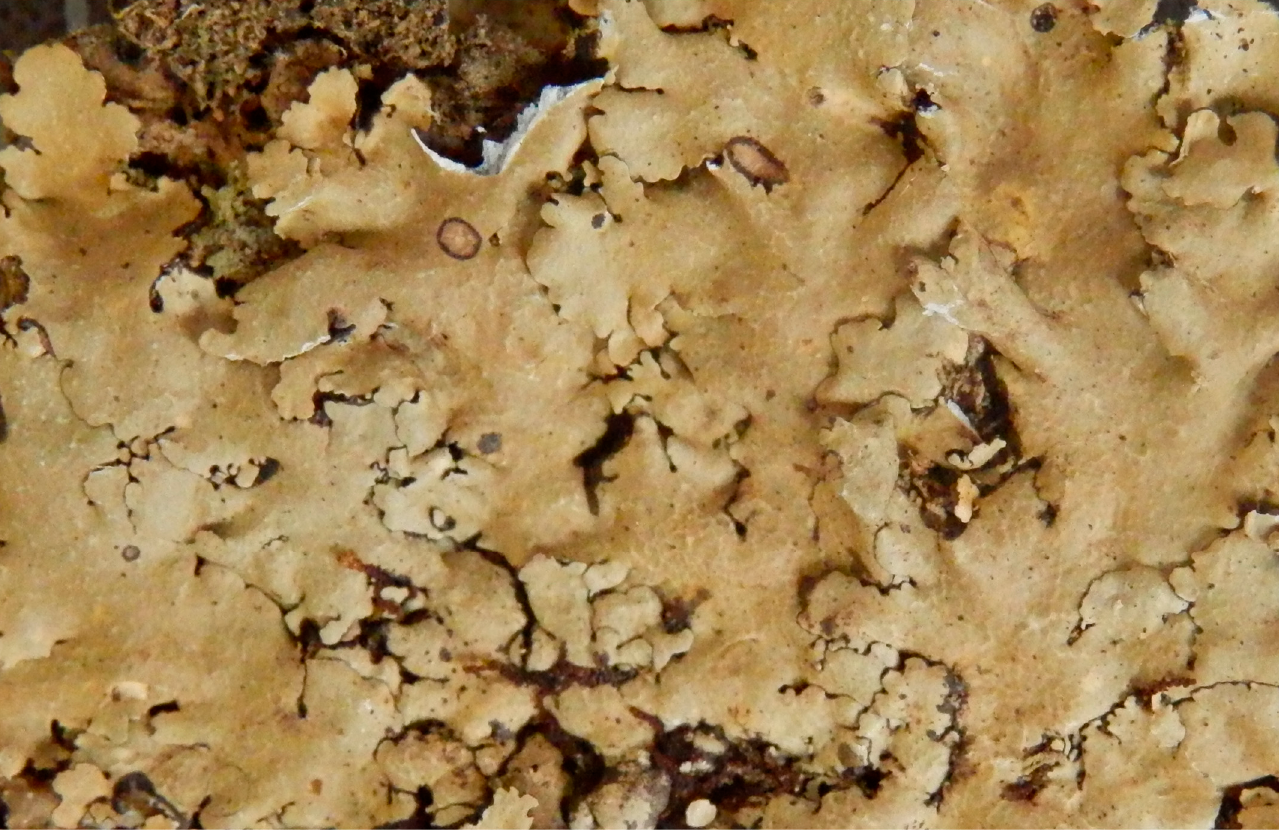
Figure 2. Canoparmelia kakamegaensis , habit (P. Kirika 3419). Ecology: Corticolous in tropical rain forest, 1760 m altitude. MycoBank No.